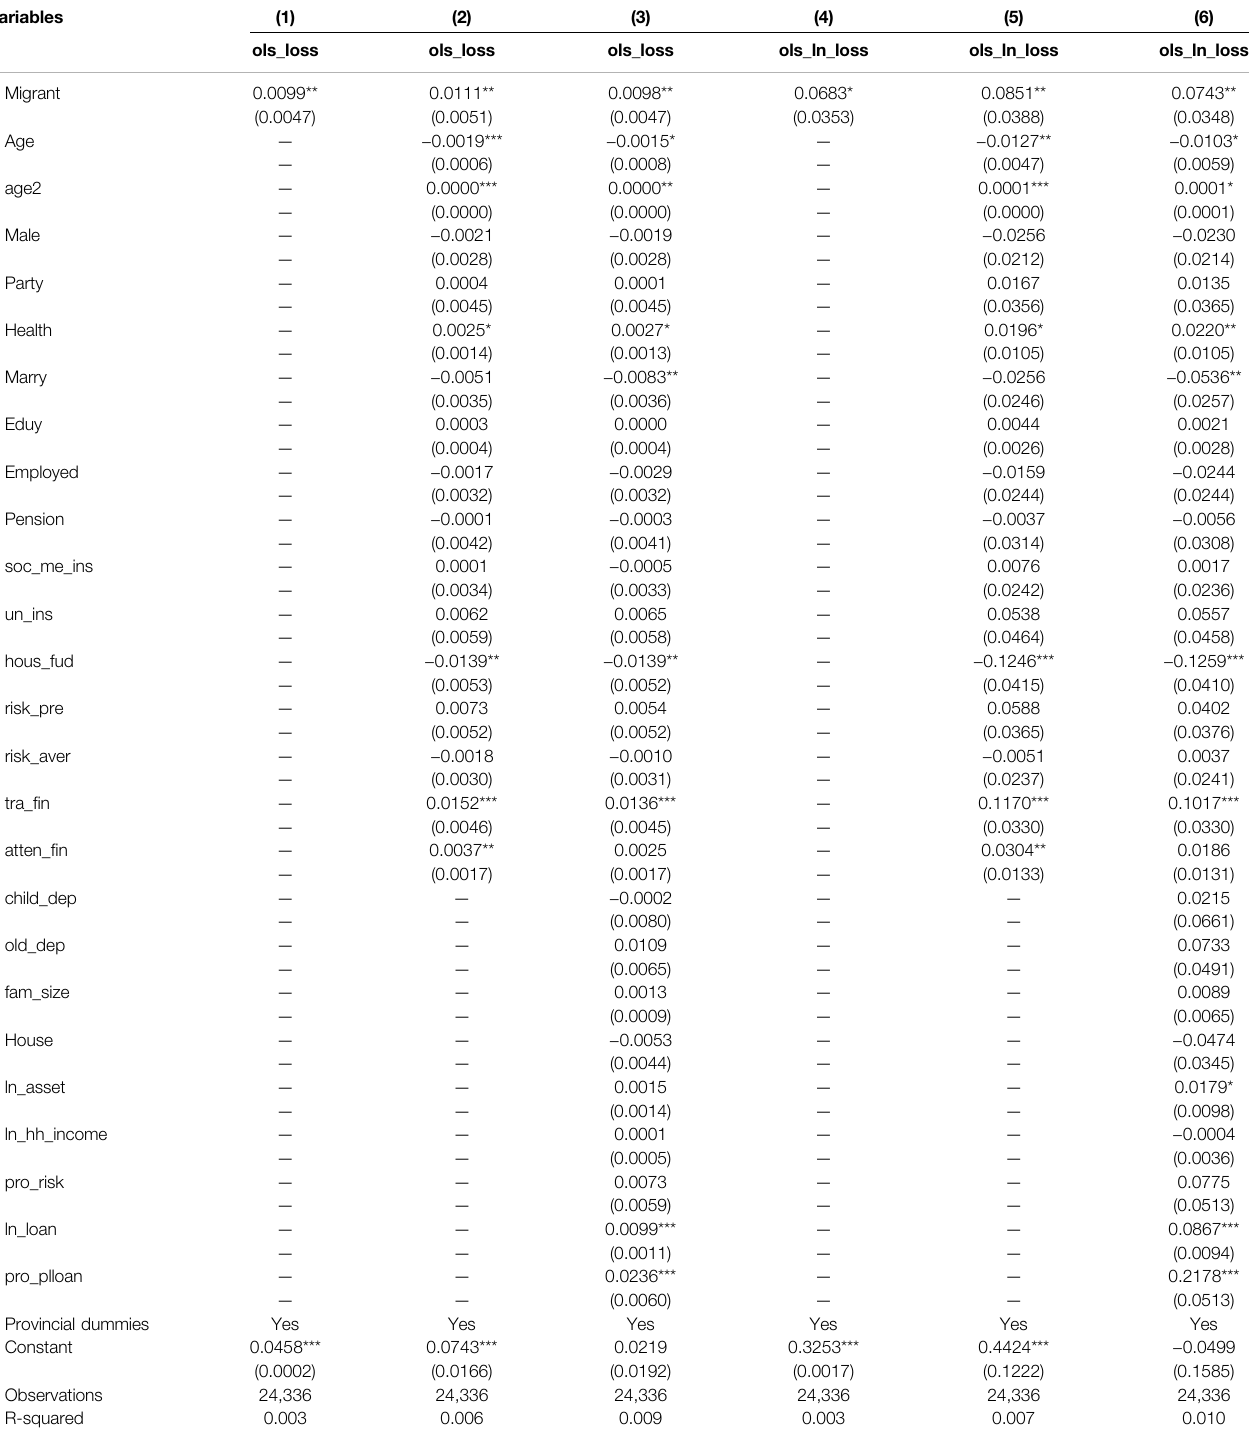
TABLE 2 | The regression of risk of households being defrauded on domestic